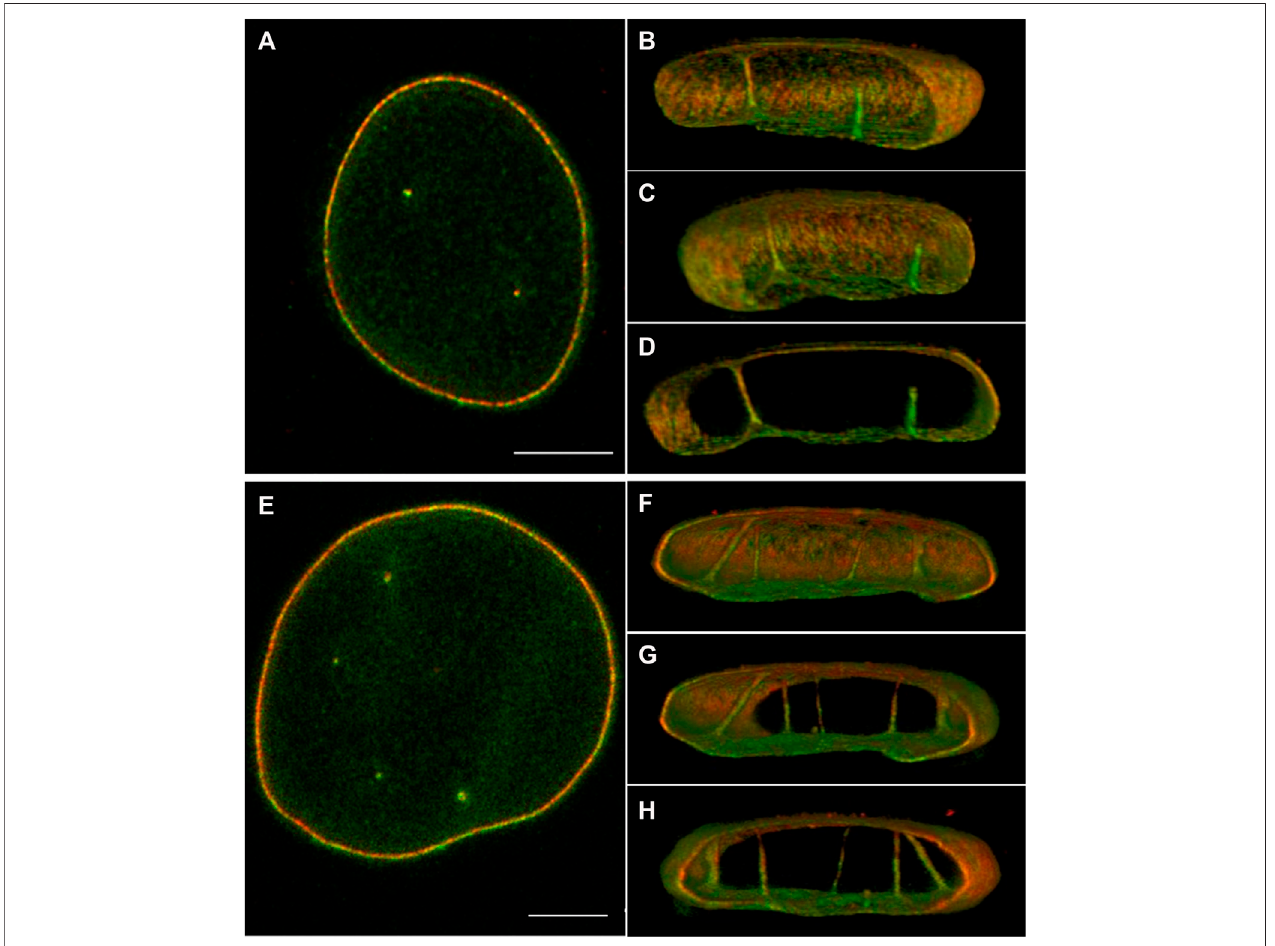
FIGURE 2 | 3D STED of normal human dermal fi broblast cells, stained for lamin A/C (red) and B1 (green). (A,E) 2D image of the middle of the nucleus. (B – D) Different 3D reconstruction views of the cell in (A) using ImageJ 3D viewer. (F – H) Different 3D reconstruction views of the cell in (E) using ImageJ 3D viewer. Scale bars indicate 5 μ m. Also see Supplementary Figures S1,S2 . Cell culture and immunostaining of NHDF was performed as described previously (Stiekema et al., 2021). STED images were taken with an abberior Instruments INFINITY LINE microscope equipped with an inverted IX83 microscope (Olympus), a 60× oil objective (UPlanXApo 60×/1.42 oil, Olympus), using pulsed excitation lasers at 561 nm (for secondary antibody Abberior STAR ORANGE) and 640 nm (for Abberior STAR RED) and a pulsed STED laser operating at 775 nm. All acquisition operations were controlled by the Lightbox Software. STED images were deconvoluted as described in Stiekema et al.